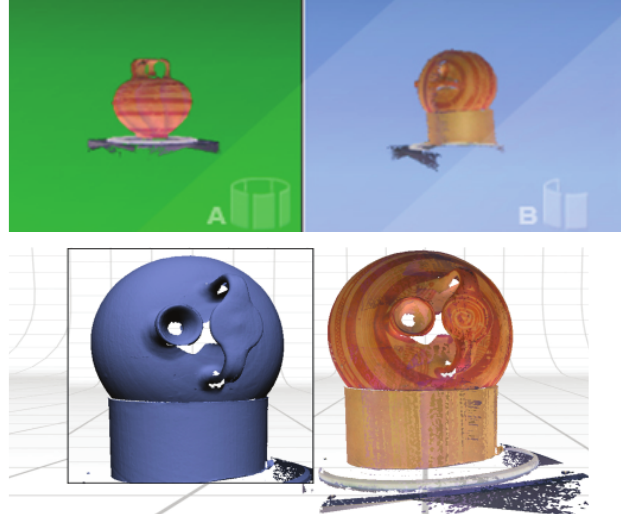
Figure 6. Below, a sequence of three scans aligned as visualized in ScanStudio; above, the different families not yet registered in the same reference